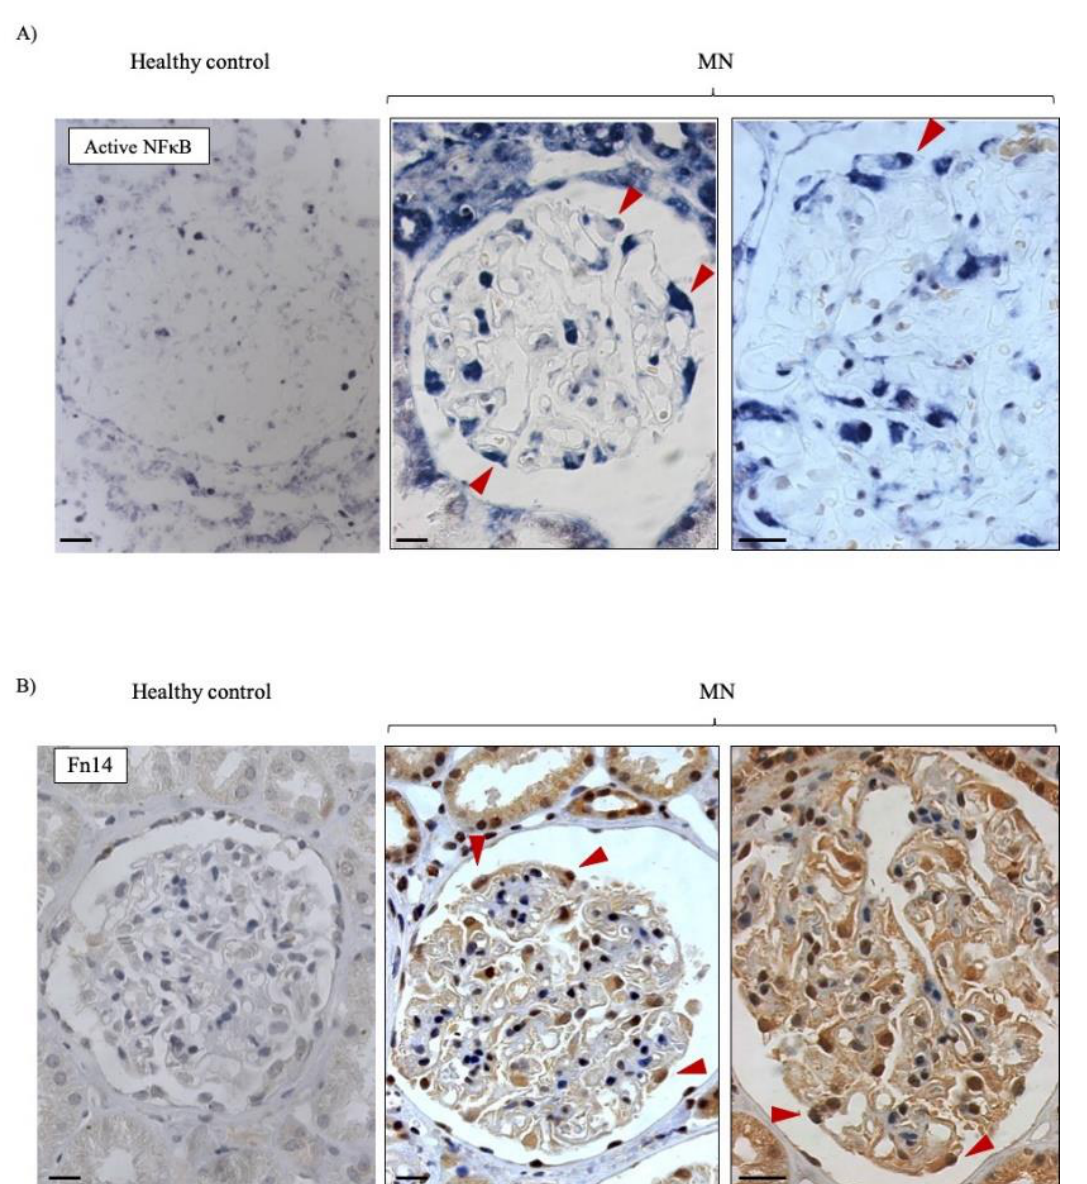
Figure 2. NFκB activation and Fn14 expression in human MN and human control kidney. ( A ) NFκB Southwestern (original magnification × 40 and × 60) and ( B ) Fn14 immunohistochemistry (Original magnification × 40 and × 60). Arrowheads point to stained cells sitting outside the capillaries and protruding towards Bowman’s capsule, consistent with podocytes. Scale bar: 20 µ m. Supplementary Figure S1 shows additional controls.